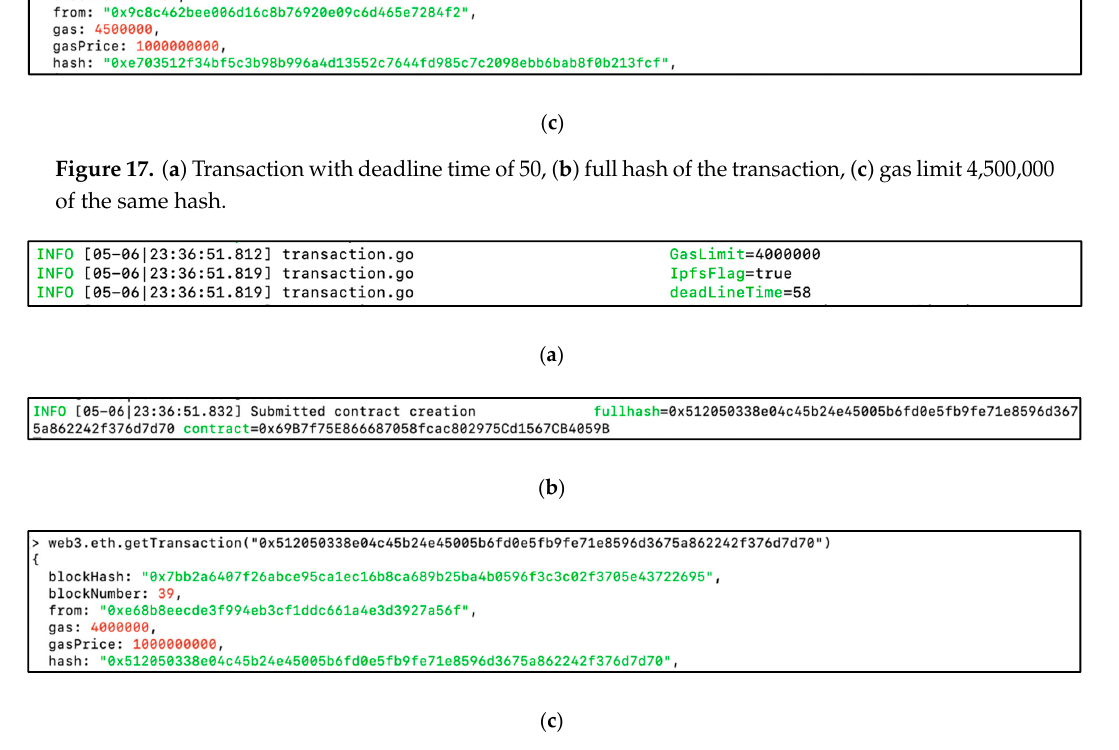
Figure 17. ( a ) Transaction with deadline time of 50, ( b ) full hash of the transaction, ( c ) gas limit 4,500,000 of the same hash.